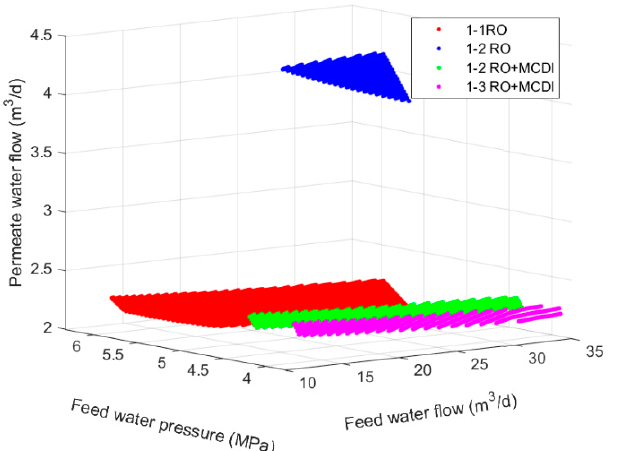
Figure 8. Relationship among feed water pressure, feed water flow rate and daily water yield of RO under constraint condition of water production.